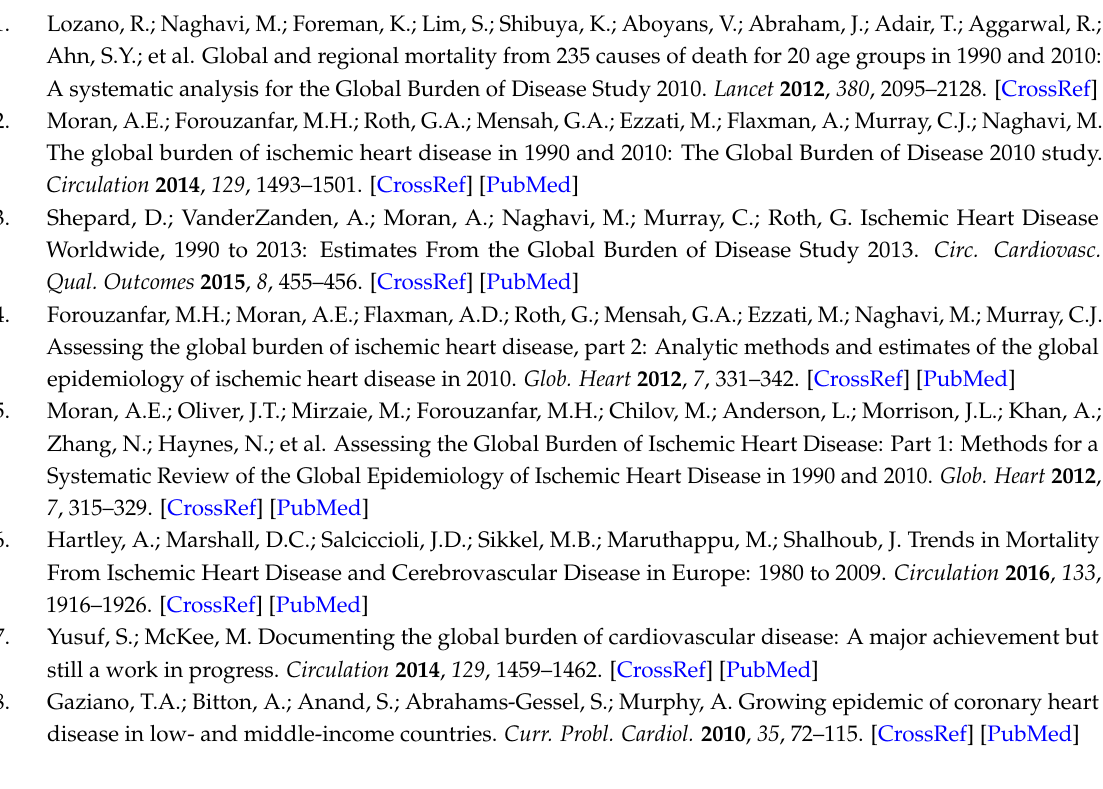
Figure S1: Adjusted ischemic heart disease (IHD) mortality rates trend in urban and rural China, 1987–2013, Figure S2: Age-period-cohort effects on IHD mortality in China (adjusted results), Figure S3: (a) Comparability between adjusted and unadjusted results of age effects on IHD mortality; (b) Comparability between adjusted and unadjusted results of period effects on IHD mortality; (c) Comparability between adjusted and unadjusted results of cohort effects on IHD mortality, Table S1: Intrinsic estimates for adjusted ischemic heart disease (IHD) mortality rates in urban and rural Chinese